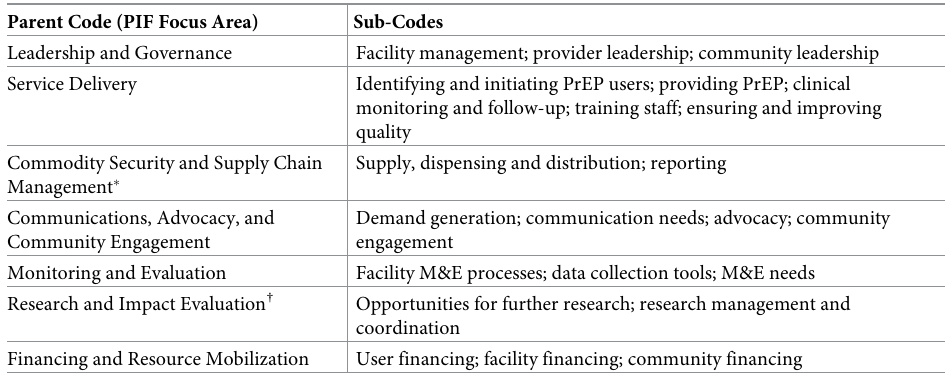
Table 1. Summary of